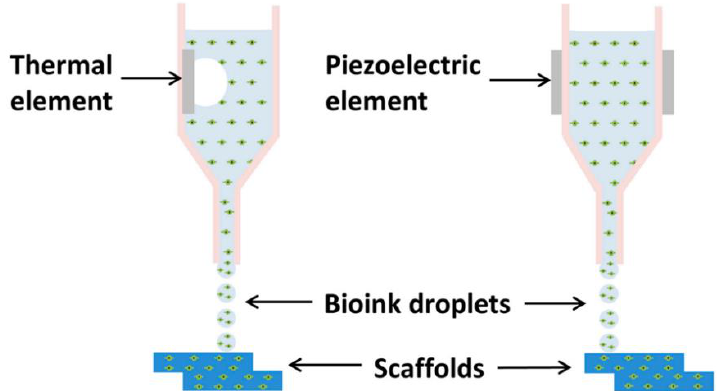
Figure 3. Schematic of Inkjet-based Bioprinting. Thermal inkjet uses heat-induced bubble nucleation that propels the bio-ink through the micro-nozzle. The piezoelectric actuator produces acoustic waves that propel the bio-ink through the micro-nozzle